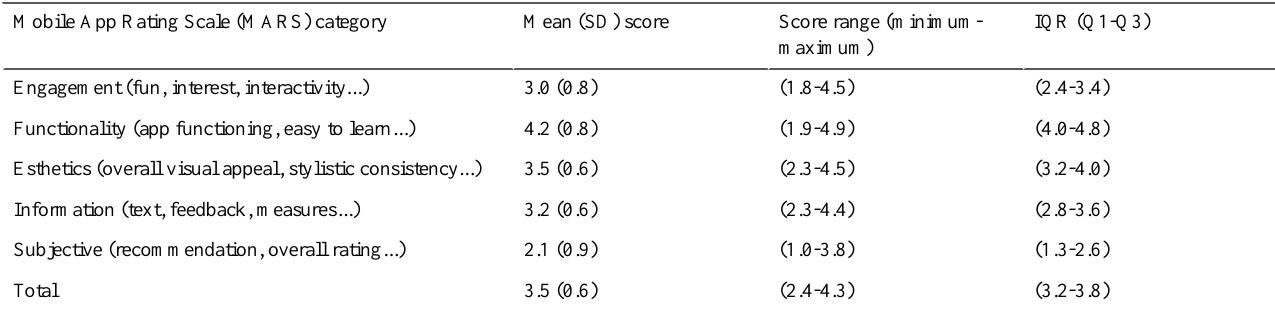
Table 2. Quality of smoking cessation mobile apps in the French market according to the Mobile App Rating Scale (MARS).